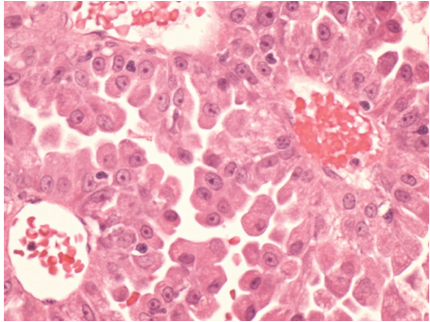
Figure 4: The microscopic examination shows rounded, polygonal